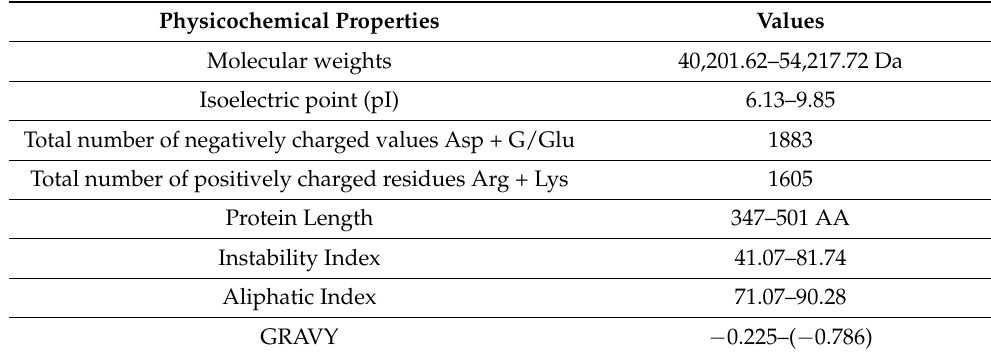
Figure 3. Gene structure of 38 zebrafish BMP sequences. ADM = Adrenomedullin, BMP = Bone morphogenic protein, GDF = Growth differentiation factor, TGF = Transforming growth factor, DVR1 = decapentaplegic-Vg-related 1, and Lefty = Left-right determination factor. Table 1. Physicochemical properties of the 38 BMP family members identified from the zebrafish